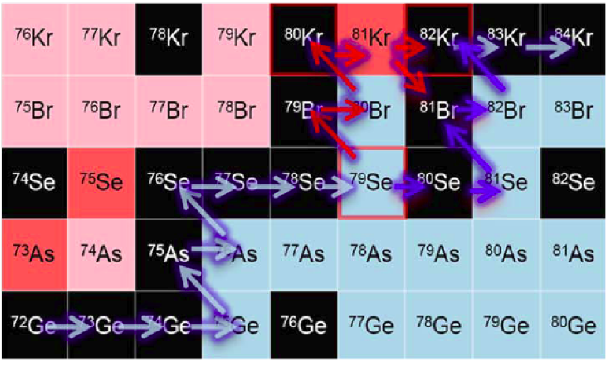
Figure 5. S-process path branching at 79 Se, which determines the ratio between the s-only 80 Kr and 82 Kr (Figure from Ref.